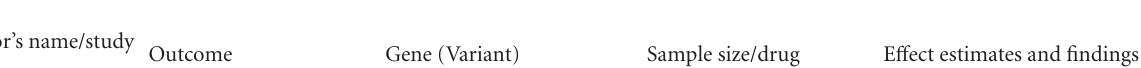
Table 4: Anticoagulants and